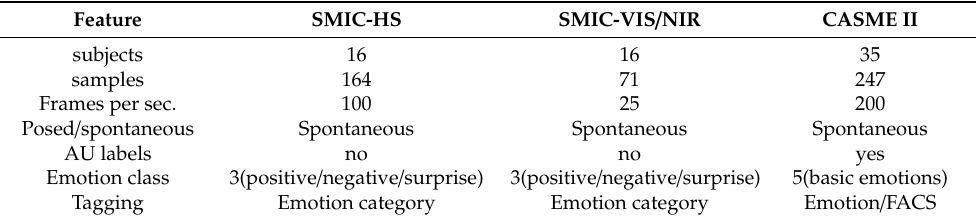
Table 2. A summary of the di ff erent features of the SMIC and CASME II